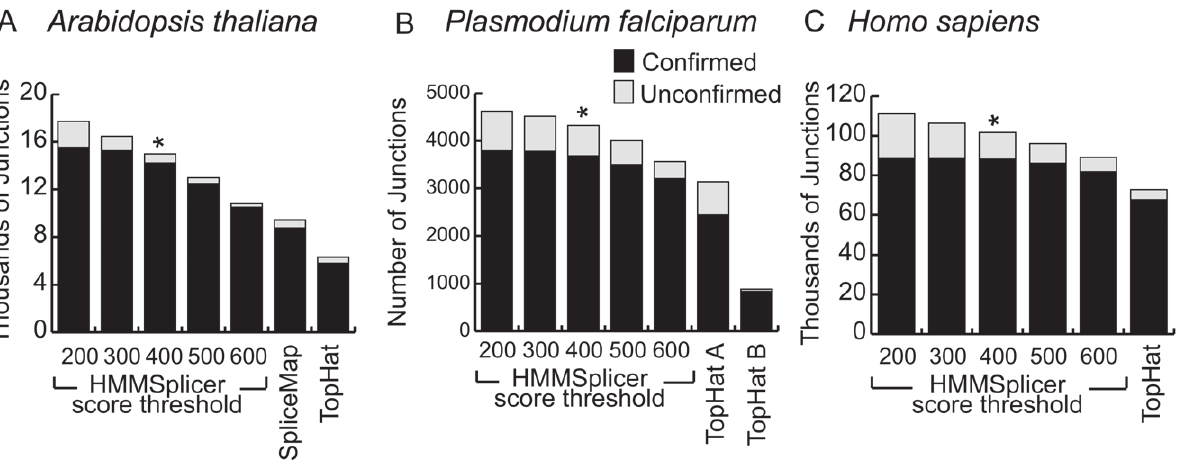
Figure 4. Overview of HMMSplicer and TopHat results in (a) A.thaliana , and (b) P.falciparum and (c) H.sapiens . For each dataset, HMMSplicer results are shown at five different score thresholds. The numbers on the bottom axis (200 to 600) are the thresholds for junctions with multiple reads; the threshold was set 200 points higher for junctions with a single read. The * indicates HMMSplicer’s default score threshold. SpliceMap results are shown for the A. thaliana dataset only, as SpliceMap cannot be run datasets with reads less than 50 nt long. For P. falciparum , TopHat was run with two different parameter sets. TopHat A was run with a segment length of 23 resulting in more junctions but a lower specificity whereas TopHat B used the default segment length of 25 resulting in fewer junctions with more specificity.